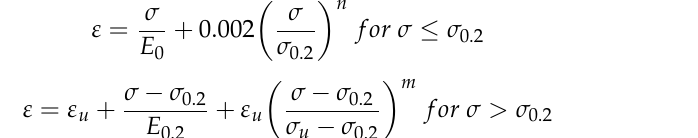
Figure 5. Material model curve of CF aluminium-Continuous Strength Method (CSM).